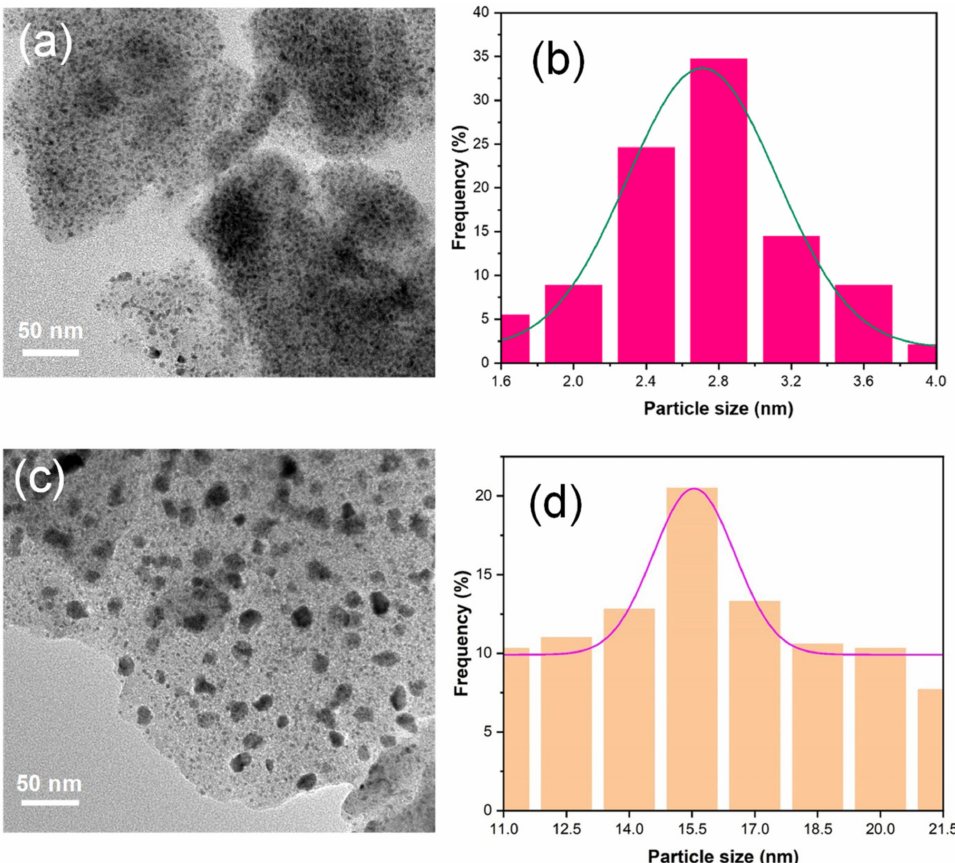
Figure 7. TEM image of ( a ) 700Ar-Du1800-Pd and ( c ) 1100Ar-Du1800-Pd samples. ( b , d ) Particle size distribution of Pd and Pd 2 Si nanoparticles in the 700Ar-Du1800-Pd and 1100Ar-Du1800-Pd samples,